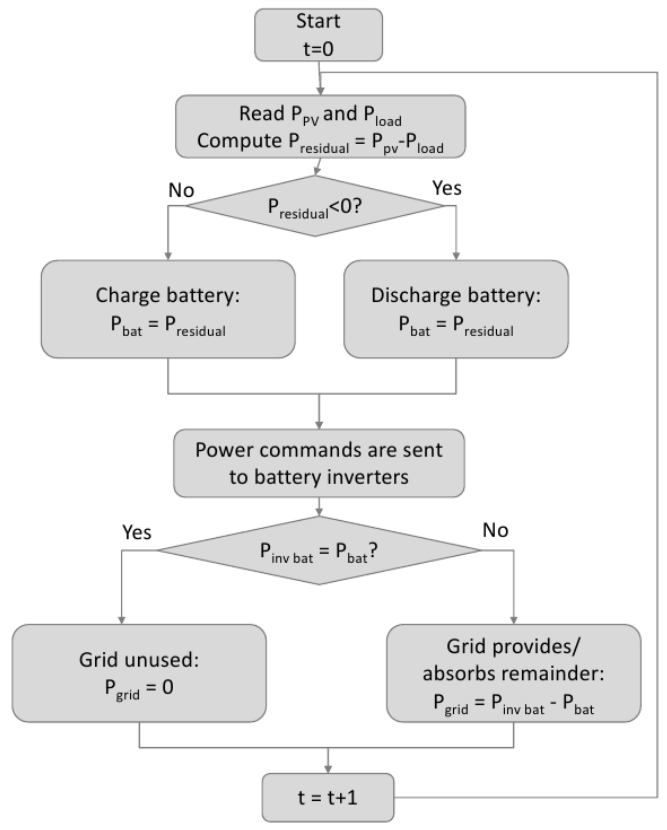
Figure 6. Flowchart of the self-consumption maximization strategy implemented in the